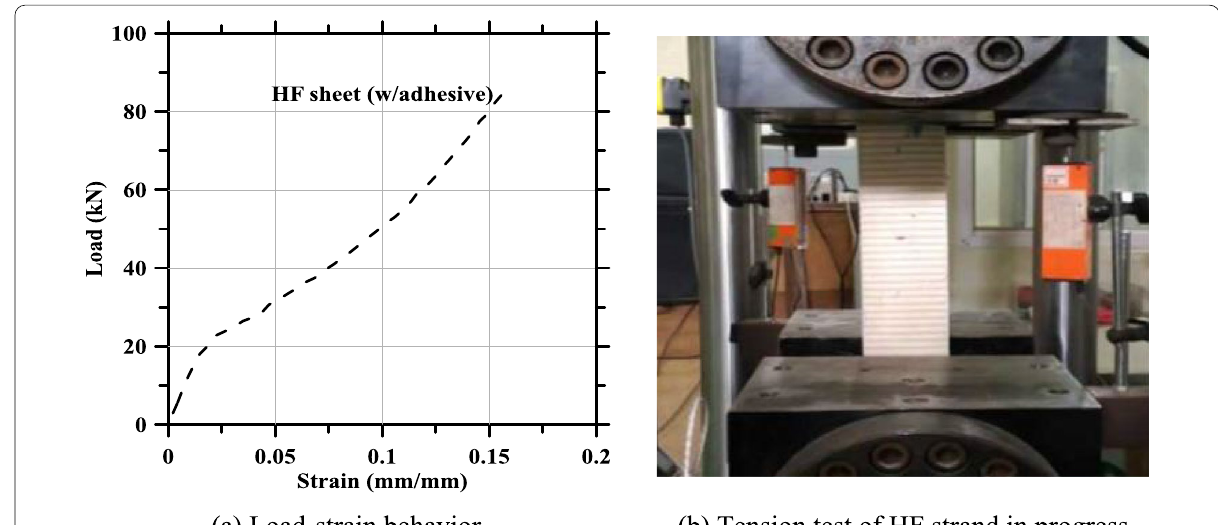
Fig. 9 Load – strain behavior of HF strand in